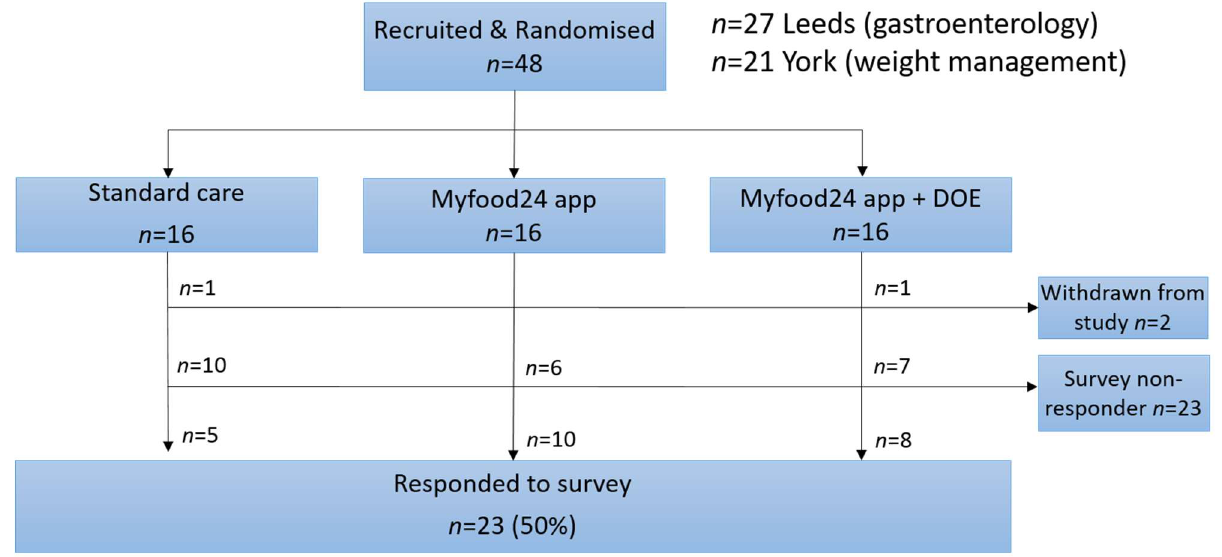
Figure 1. Flowchart of group allocation and survey response.